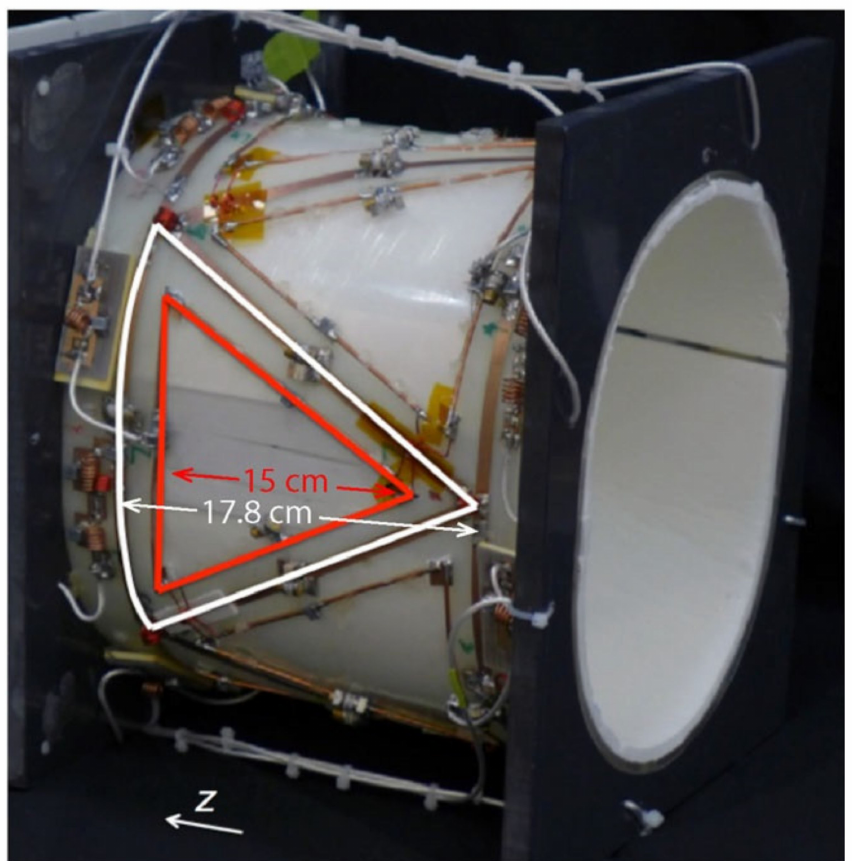
Figure 13. The eight-channel sodium/hydrogen coil array, where one sodium and one hydrogen element are coloured in white and red, respectively. Reprinted by permission from Lakshmanan et al., NMR in Biomed 2017